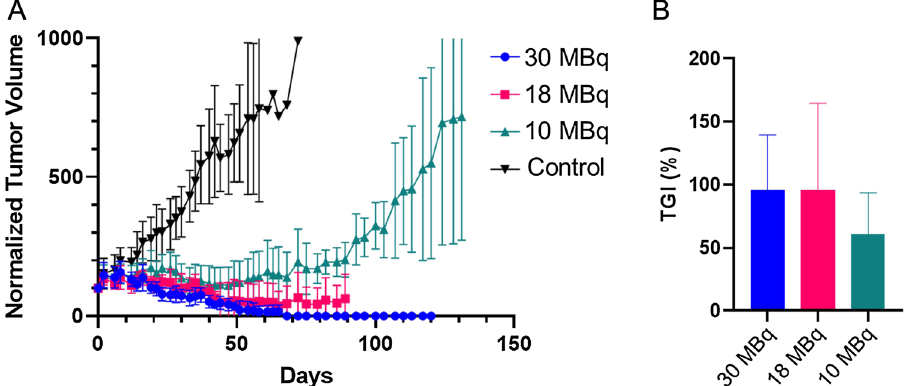
Figure 4. Effect of four doses of iso -[ 131 I]SGMIB-VHH_1028 on tumor growth of BT474 xenografts in SCID mice. ( A ) Normalized tumor volume as a function of time. ( B ) Tumor growth inhibition (TGI%) of the treatment